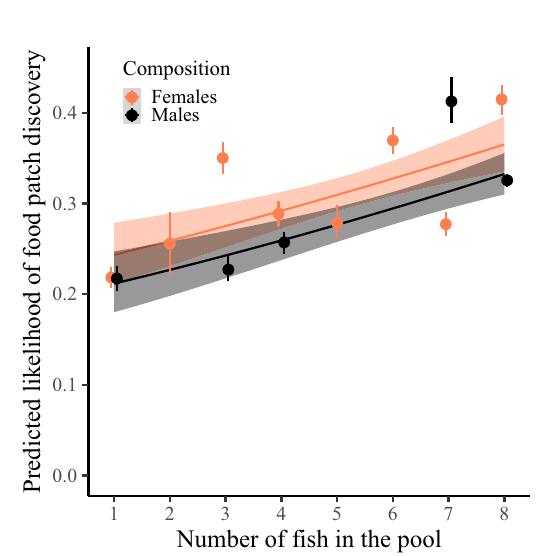
(Table 2). Trial number did not affect how quickly an individual (Table 2). Also when looking at recruitment latency (de fi ned as the time between the arrival of the fi rst and second fi sh), we found no difference between males and females (Supplementary Note 1).